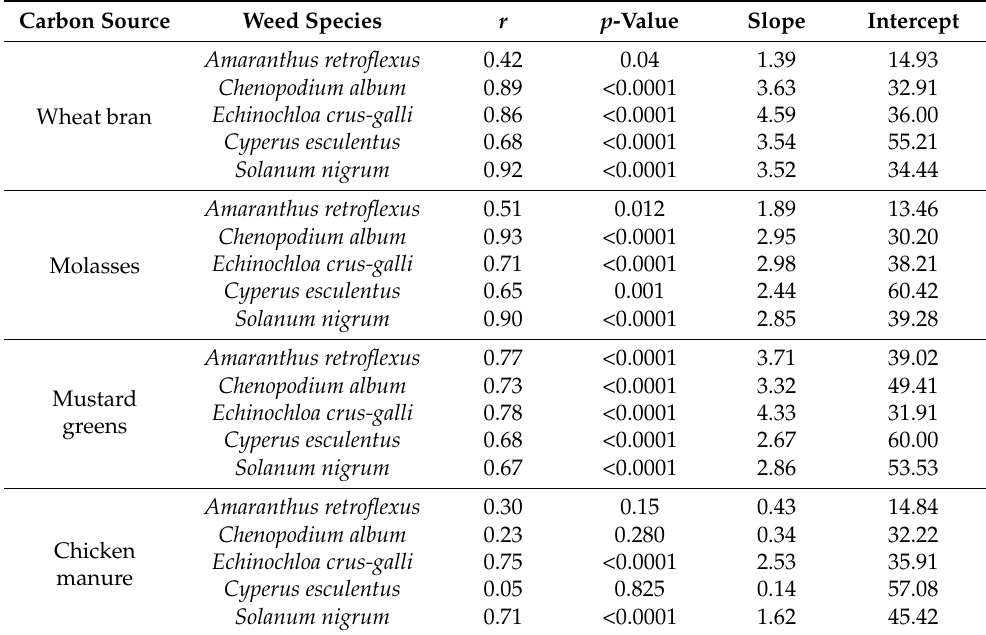
Table 6. Correlations between anaerobic soil disinfestation (ASD) carbon source rates and propagule mortality of various weed species from experiments under growth chamber conditions.